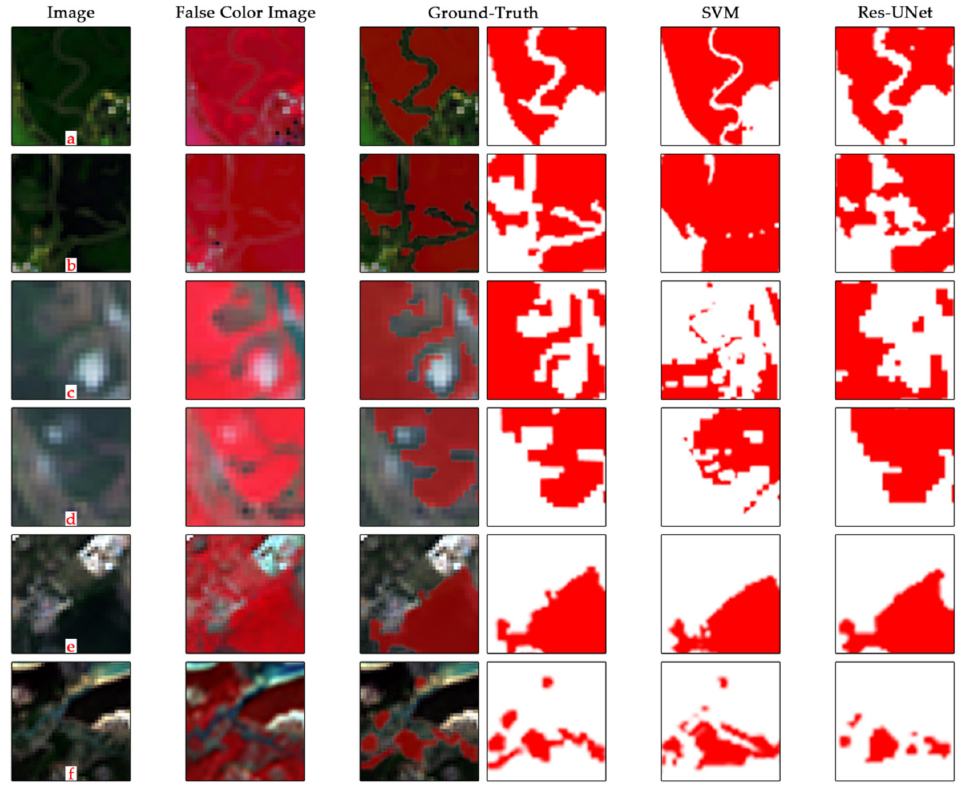
Figure 6. Illustrative examples of the classification method limitations for SVM and Res-UNet: white represents all other land types, each square is captured from a 30 m Landsat remote sensing image, and the side length is about 975 × 975